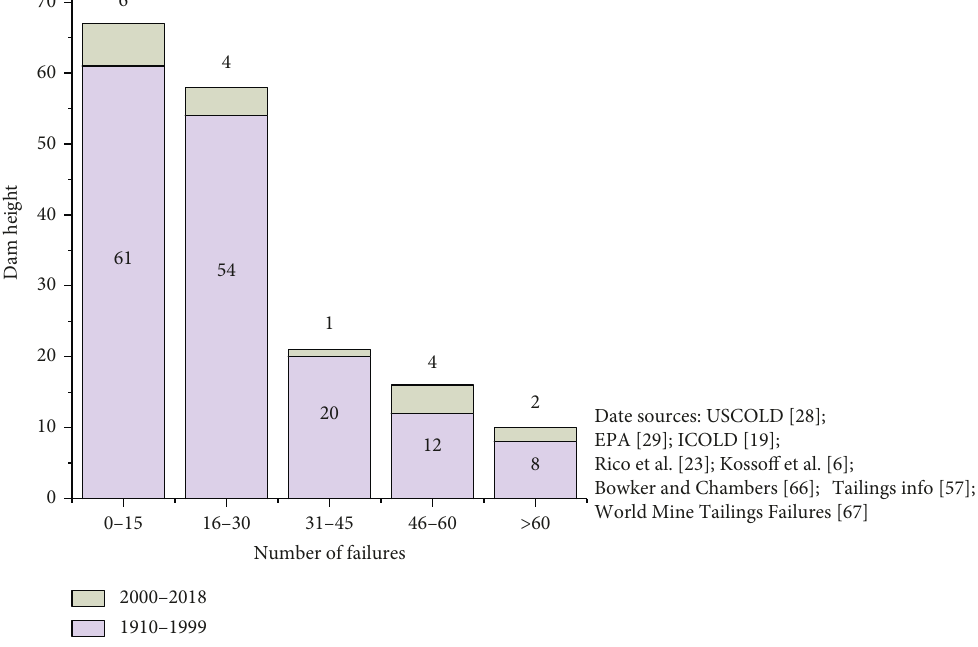
Figure 7: Failure distribution by tailings dam